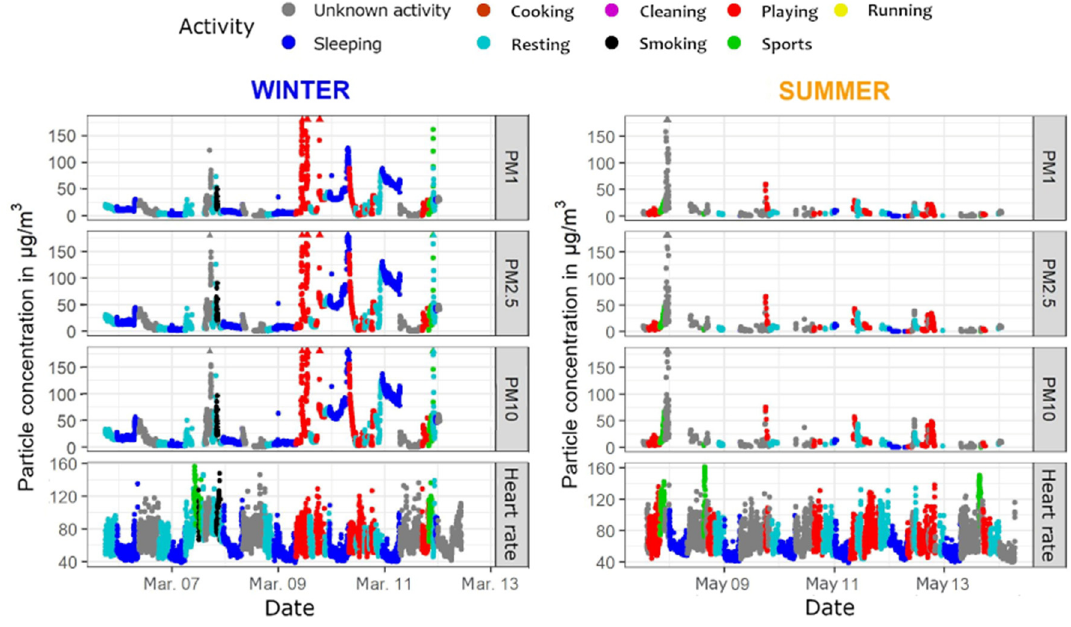
Figure 4. Three size classes of PM (PM 1 , PM 2.5 , and PM 10 ) and heart rate values for both seasons with each point colored according to the associated activity; data from PPM, SAT, and TAD.